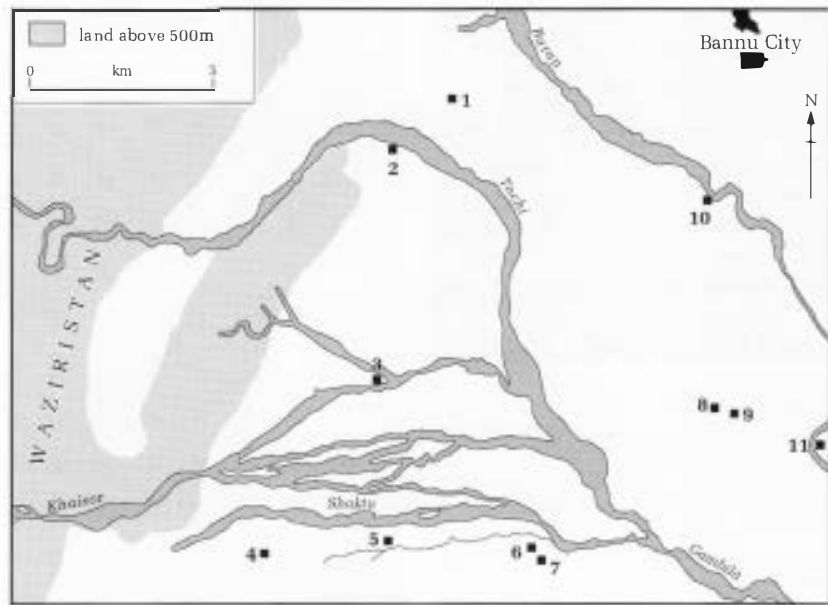
Figure 3 The northwestern Bannu basin, southwest of Bannu City, showing the distri­ bution of late prehistoric sites and the early historic site of Akra. (1) Islam Chowki, (2) Tarakai Qila, (3) Girdai, (4) Tarakai Ghundai, (5) Sheri Khan Tarakai, (6) Barrai Khuarra I, (7) Lak Largai, (8) Lewan, (9) Seer Dheri, (10) Ter Kala Dheri, (11)